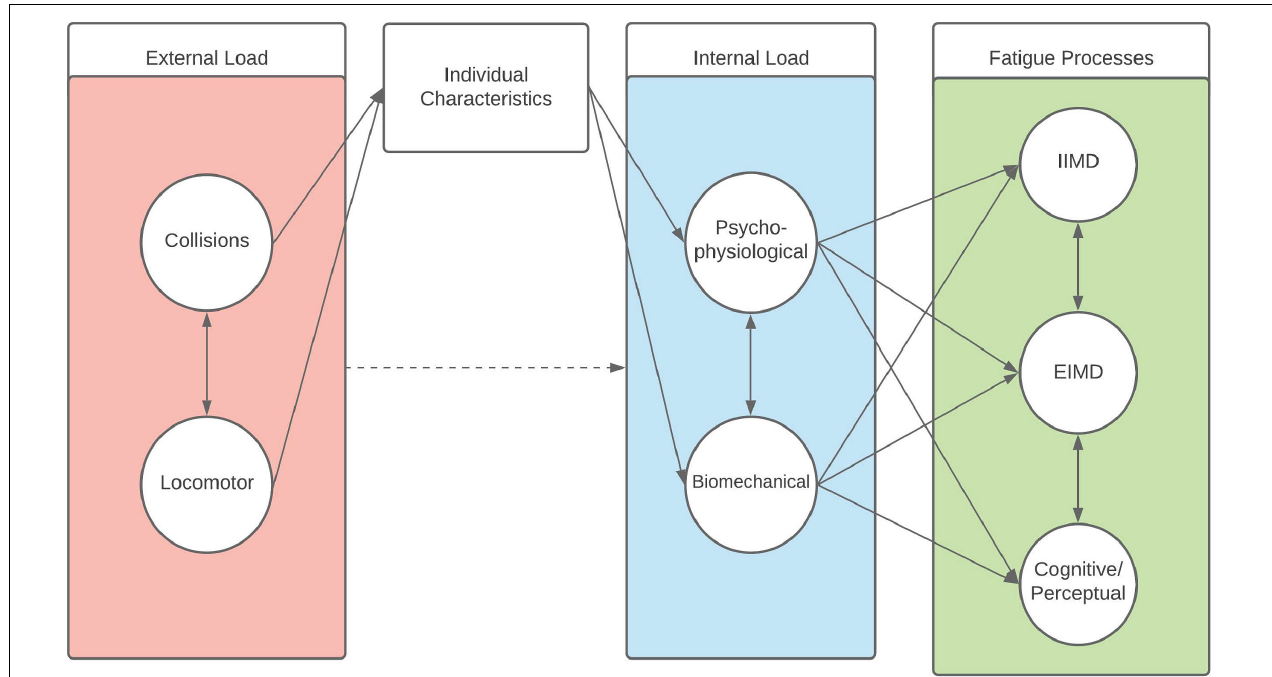
FIGURE 2 | A latent structural equation model conceptualisation of the relationship between external load factors, individual characteristics, internal load, and fatigue generating processes [including impact-induced muscle damage (IIMD), and exercise-induced muscle damage (EIMD)] in rugby. Circles represent a construct, rectangles represent an indicator of a construct, single arrows indicate a causal relationship, double-headed arrows represent a bi-directional relationship (e.g., covariance/correlation), and the dashed arrow represents an effect which may be mediated.